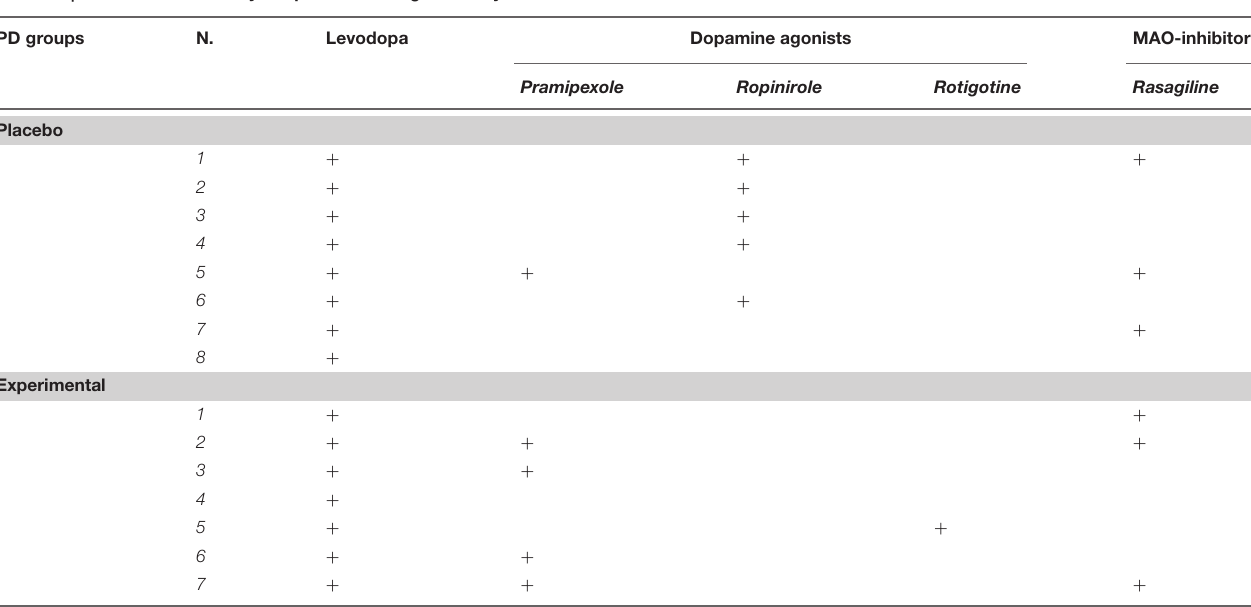
TABLE 2 | Medications taken by the patients during the